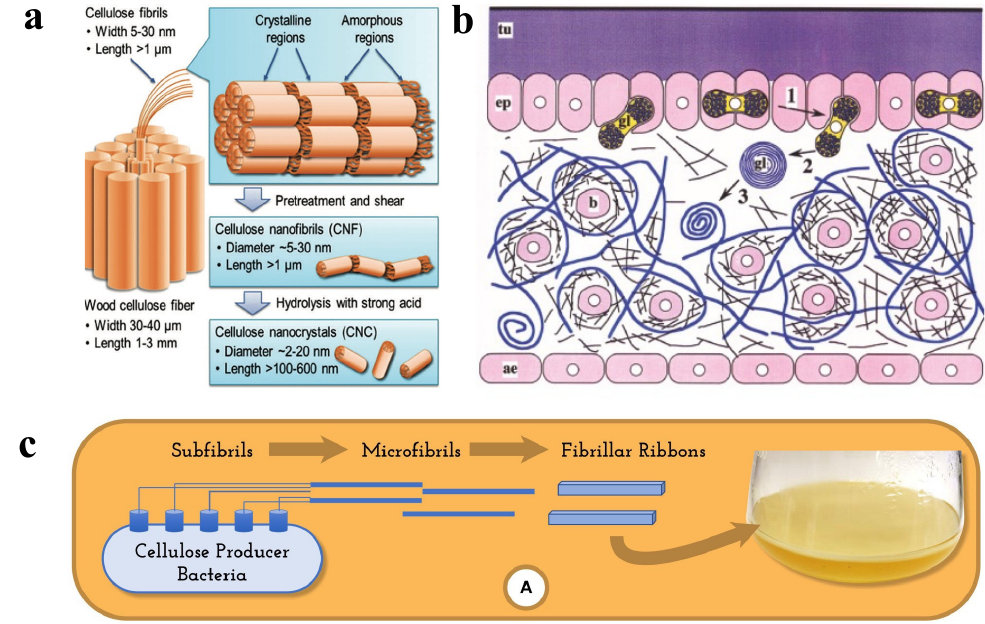
Figure 2. Biosynthesis of ( a ) wood cellulose, reprinted with permission from [35], 2016, ACS; ( b ) tunicate cellulose, reprinted with permission from [36], 2007, Springer; and ( c ) BC, reprinted with permission from [37], 2019, Frontiers Media S.A.